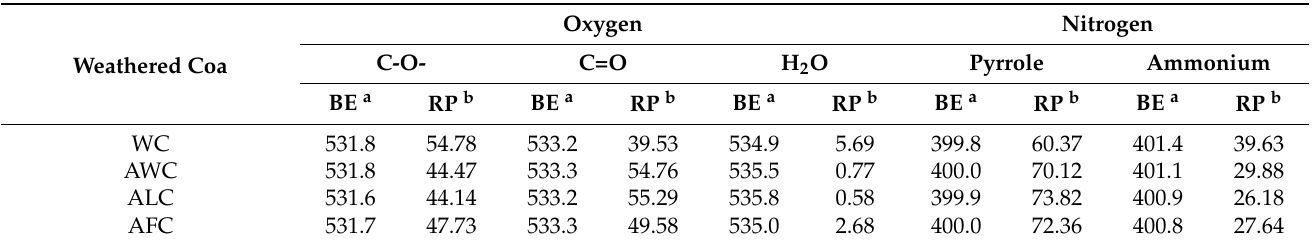
Table 3. Relative distribution of oxygen and nitrogen functional groups in weathered coal humic acid by XPS.